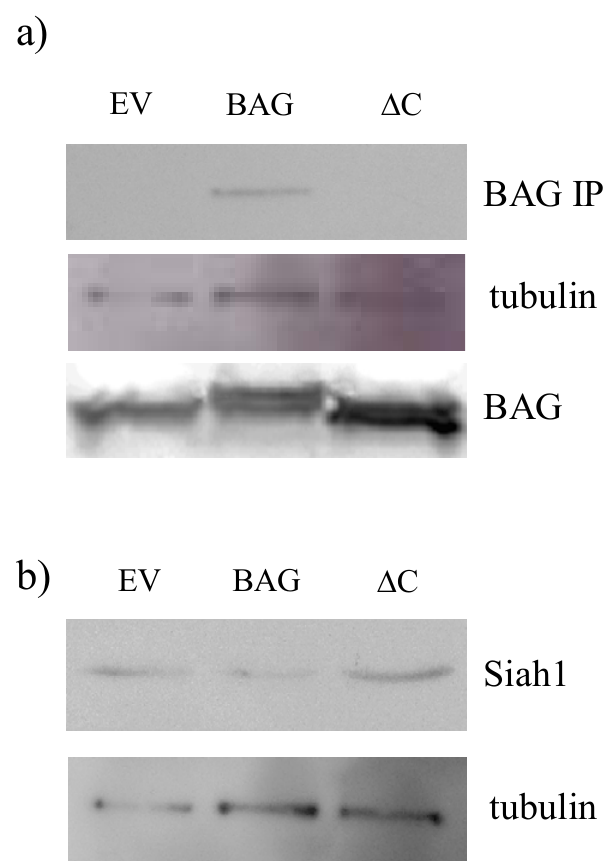
Figure 1. (a) BAG1, but not BAG Δ C binds to